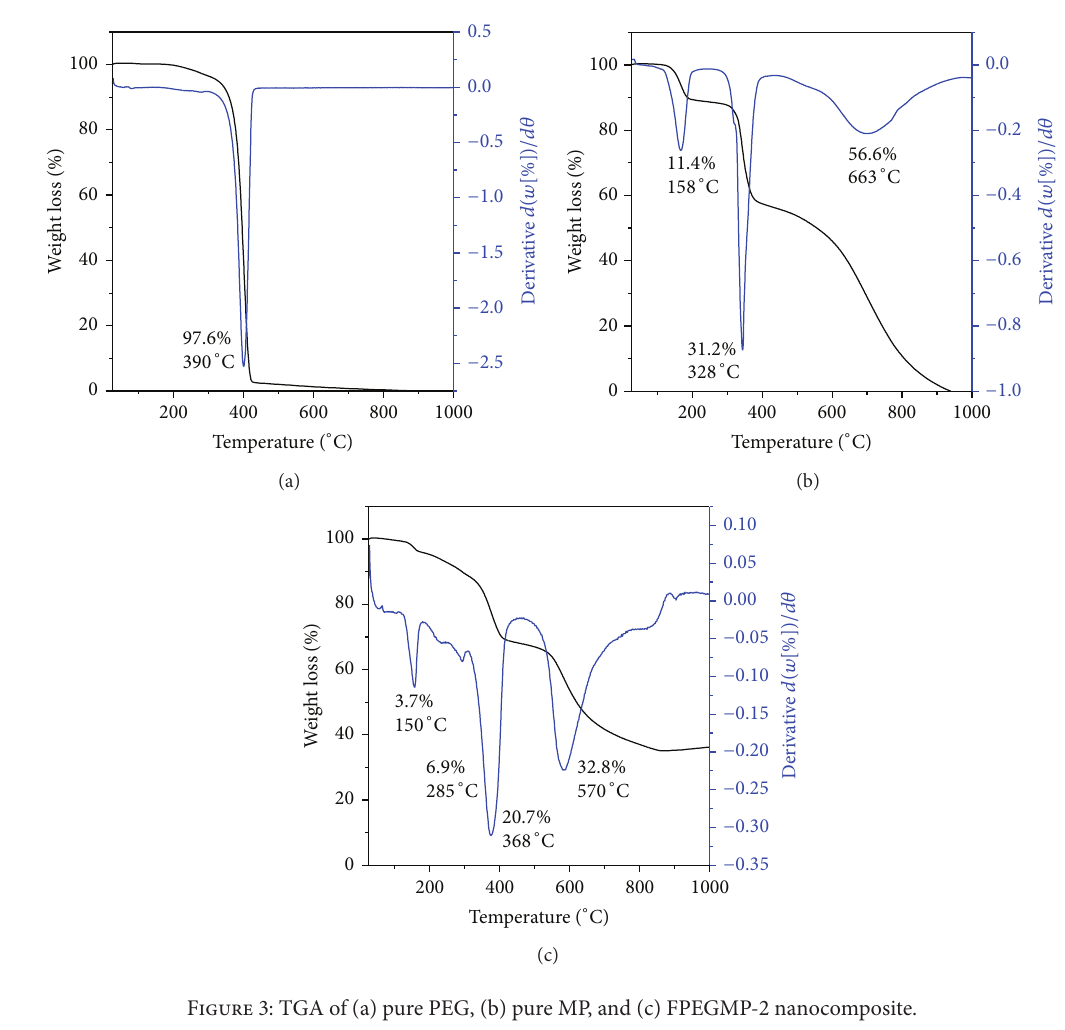
Figure 3: TGA of (a) pure PEG, (b) pure MP, and (c) FPEGMP-2 nanocomposite.